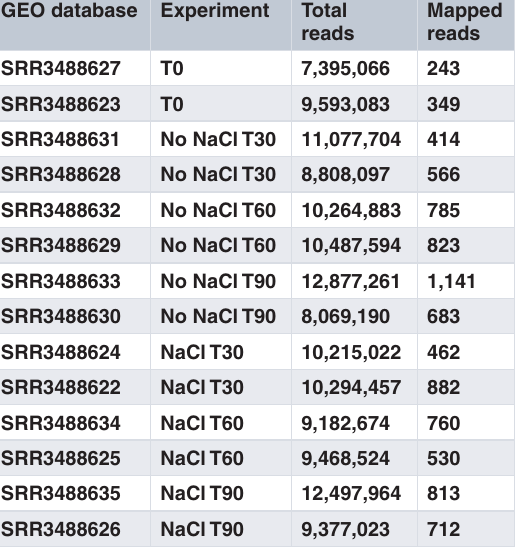
Table 1. Distribution of mapped reads for tRNA Cys in dormant spore and outgrowth in presence and absence of 1.2 M